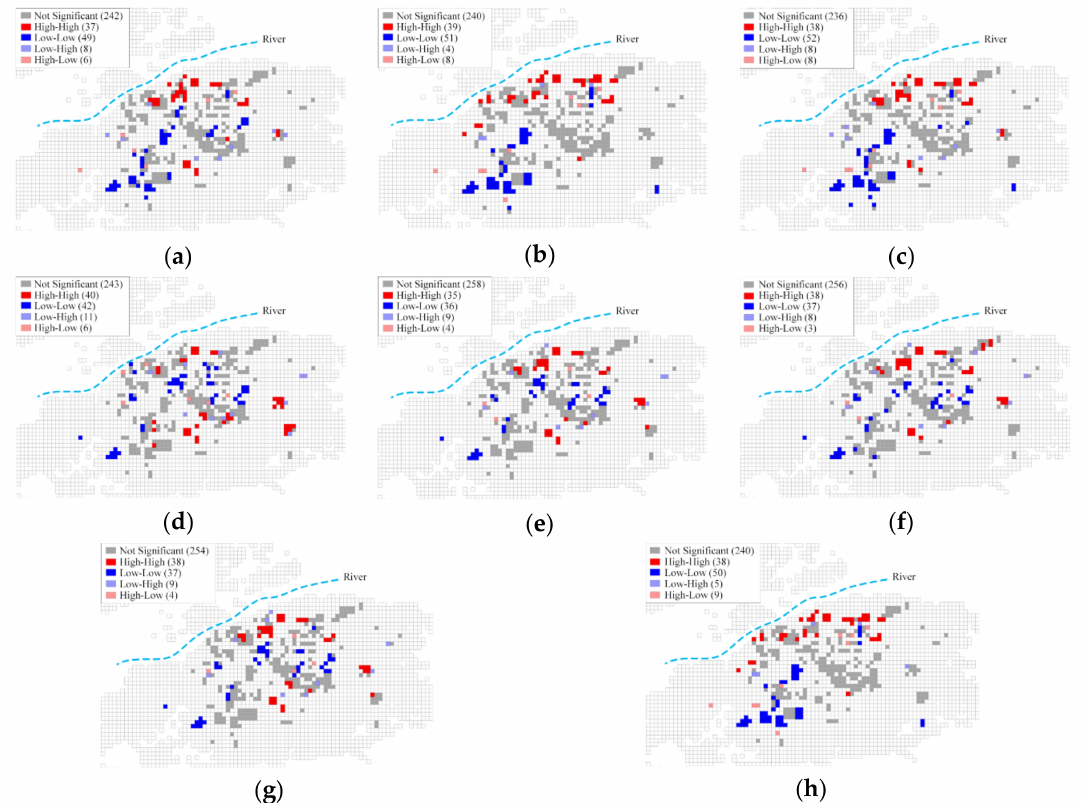
Figure 11. LISA cluster map of heating EUI: ( a ) annual; ( b ) January; ( c ) February; ( d ) March; ( e ) April; ( f ) October; ( g ) November; ( h )